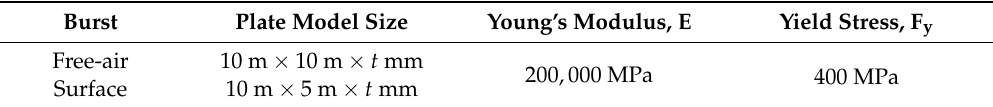
Table 7. Properties of Plate Models.